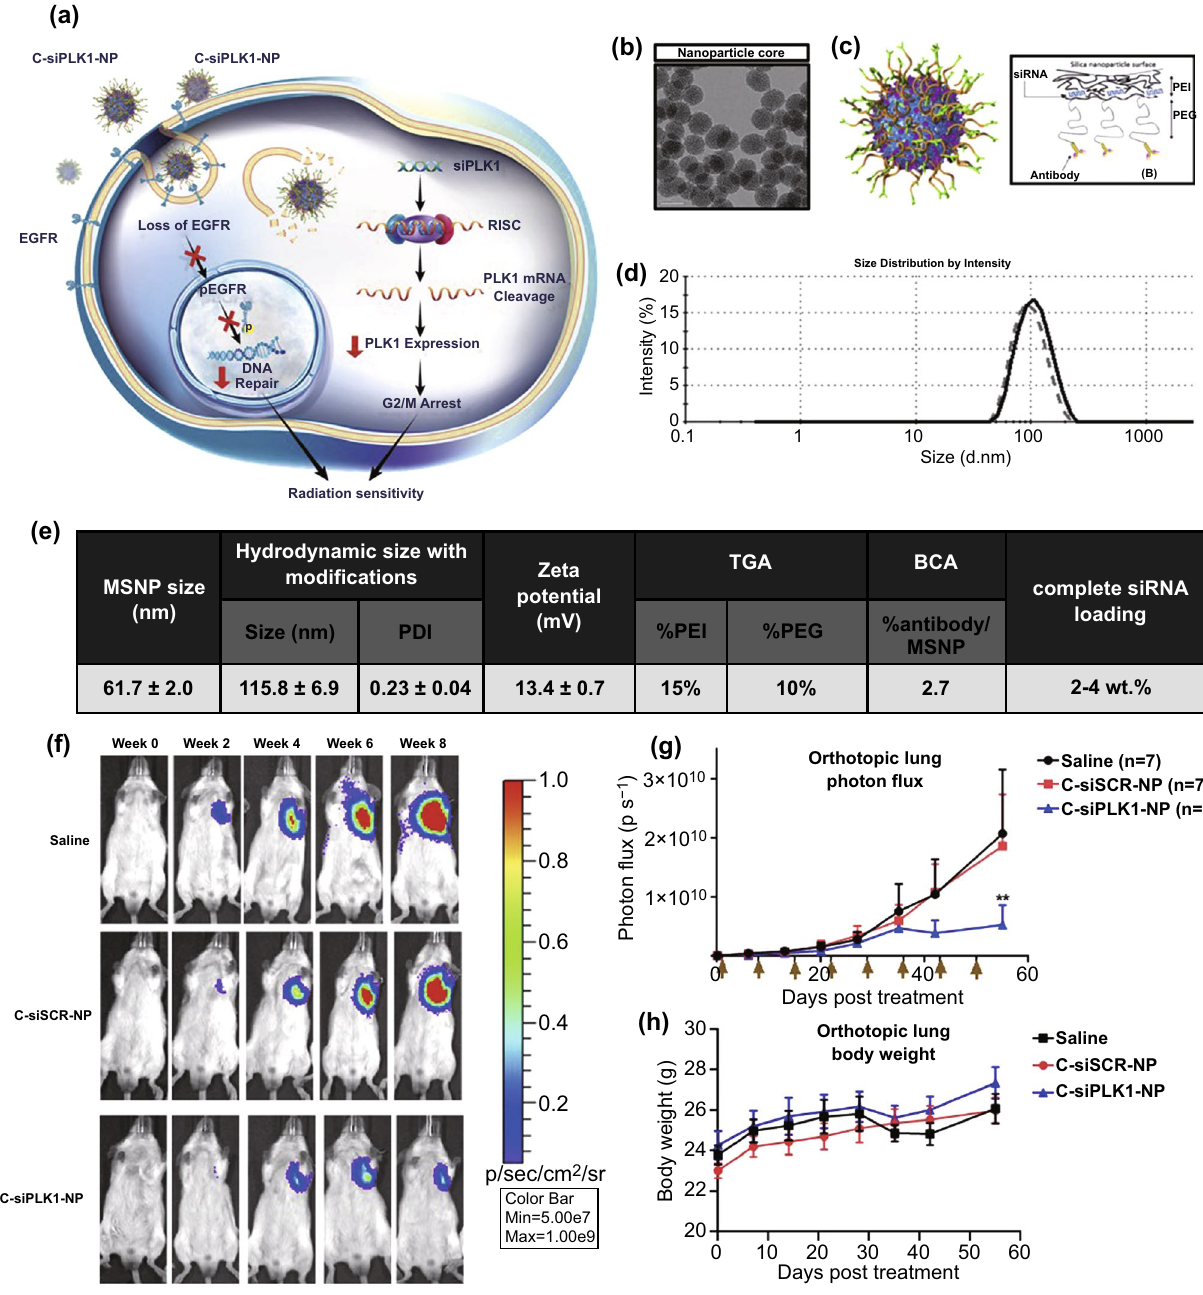
Fig. 7 Cetuximab-conjugated mesoporous silica nanoparticles (MNP) loaded with PLK1 siRNA (siPLK1) or C-siPLK1 for EGFR-targeted delivery. a radiosensitization strategy with combined EGFR antibody and siPLK1-nanoparticles. The C-siPLK1-NPs bind to EGFR receptors and are endocytosed to result in loss of EGFR and phosphorylated EGFR to initiate DNA repair, while reducing DNA damage due to radiation and releasing the siPLK1 to cytosol. The siPLK1 reduces the PLK1 protein expression and arrests cell arrest at G2/M, thereby sensitizing the cells to radiation damage. b TEM microscopic images of 50-nm MNPs. c Layer-by-layer surface-conjugated nanoparticles. d Hydrodynamic diameter of C-NP (solid lines) and without siRNA(dotted lines). e Particle size, zeta potential and other characteristics like drug loading and antibody conjugation of C-siRNA-NPs expressed as mean ± SD. f IVIS imaging in orthotopic lung tumor-induced mice after being treated with C-siPLK1-NP, C-siSCR-NP, or saline. g Tumor growth determined using photon flux in prone and supine position of the treated mice ( n = 7–8). Arrows indicating days of treatment. (H) Body weight of mice post-therapy. Adapted from Ref. [322] with permission from Elsevier, Copyright